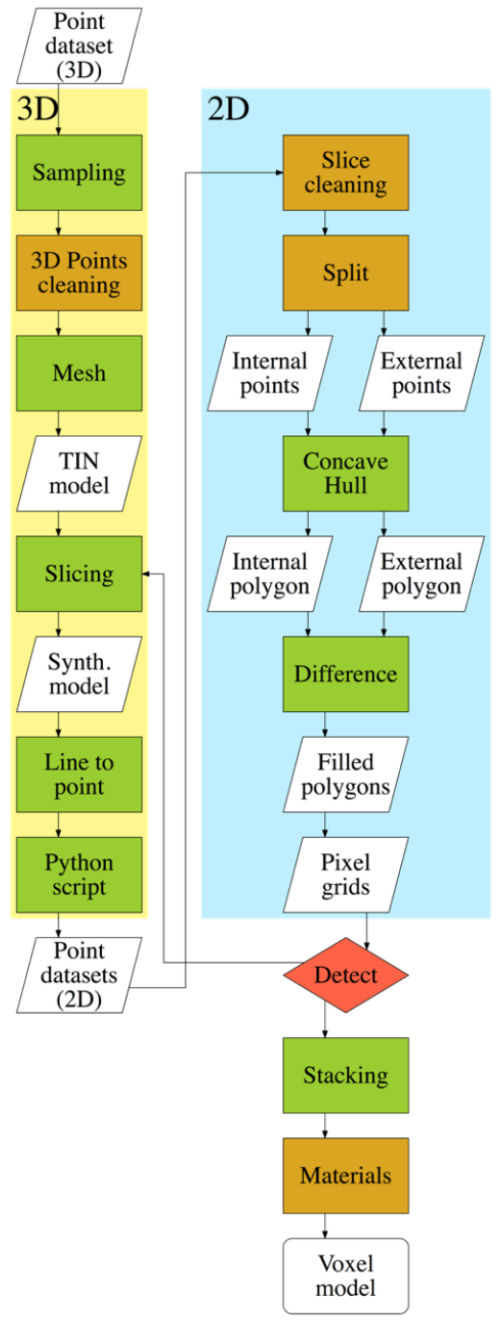
Figure 3. Flowchart for the proposed method: completely automated procedures (green), semi-automated or manual procedures (orange) and the algorithm for the new proposed approach